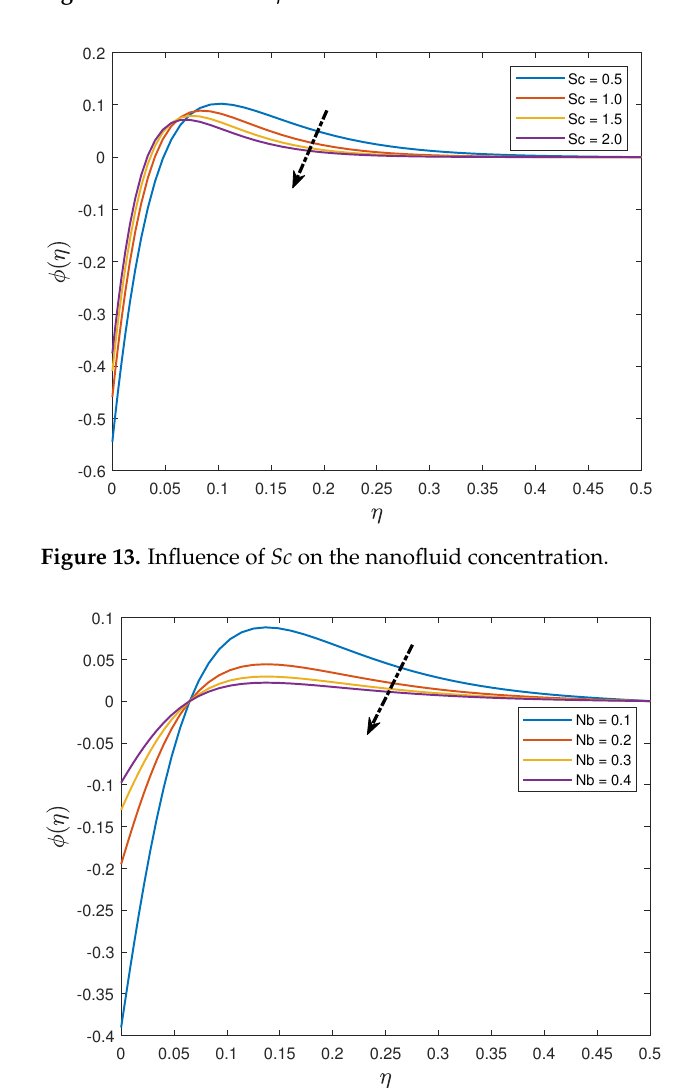
Figure 12. Influence of γ on the nanofluid concentration.